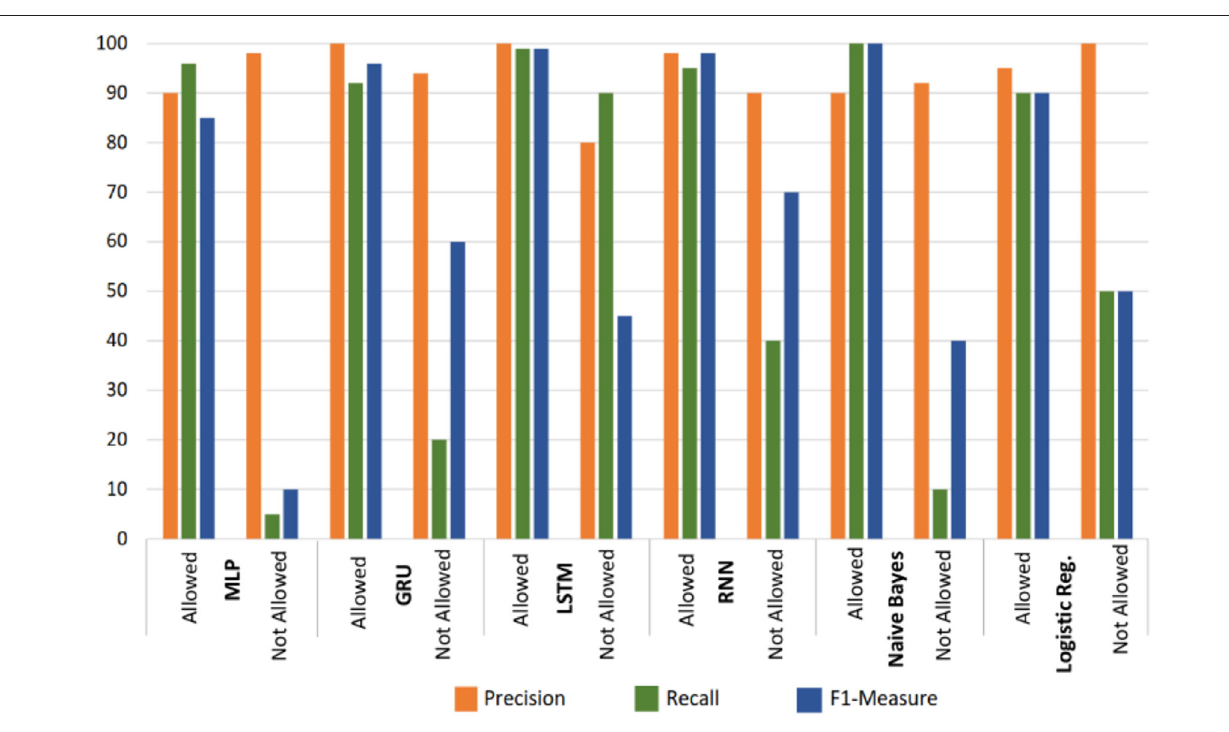
score began from 0.45 and decreased to 0.14. In the same way, testing loss performance commenced from 0.38 down to